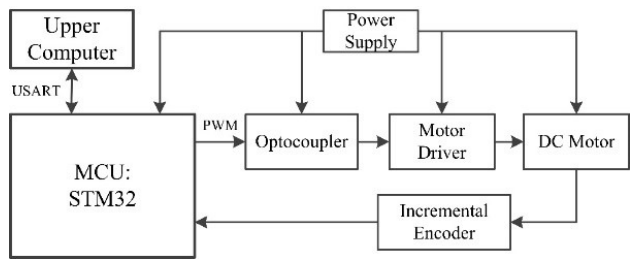
Figure 3. Control block diagram of the robot.